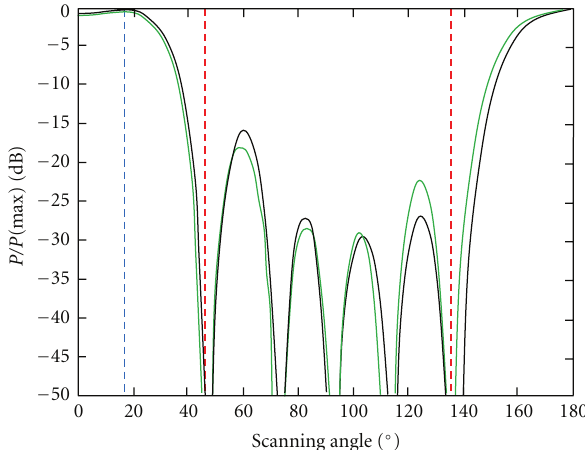
Figure 22: An ANN beam pattern pointed towards the useful signal with the angle of 15